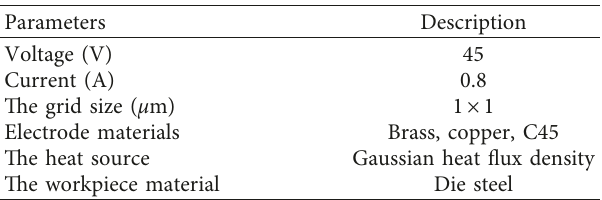
Table 2: Simulation parameters of single-pulse removal volume in